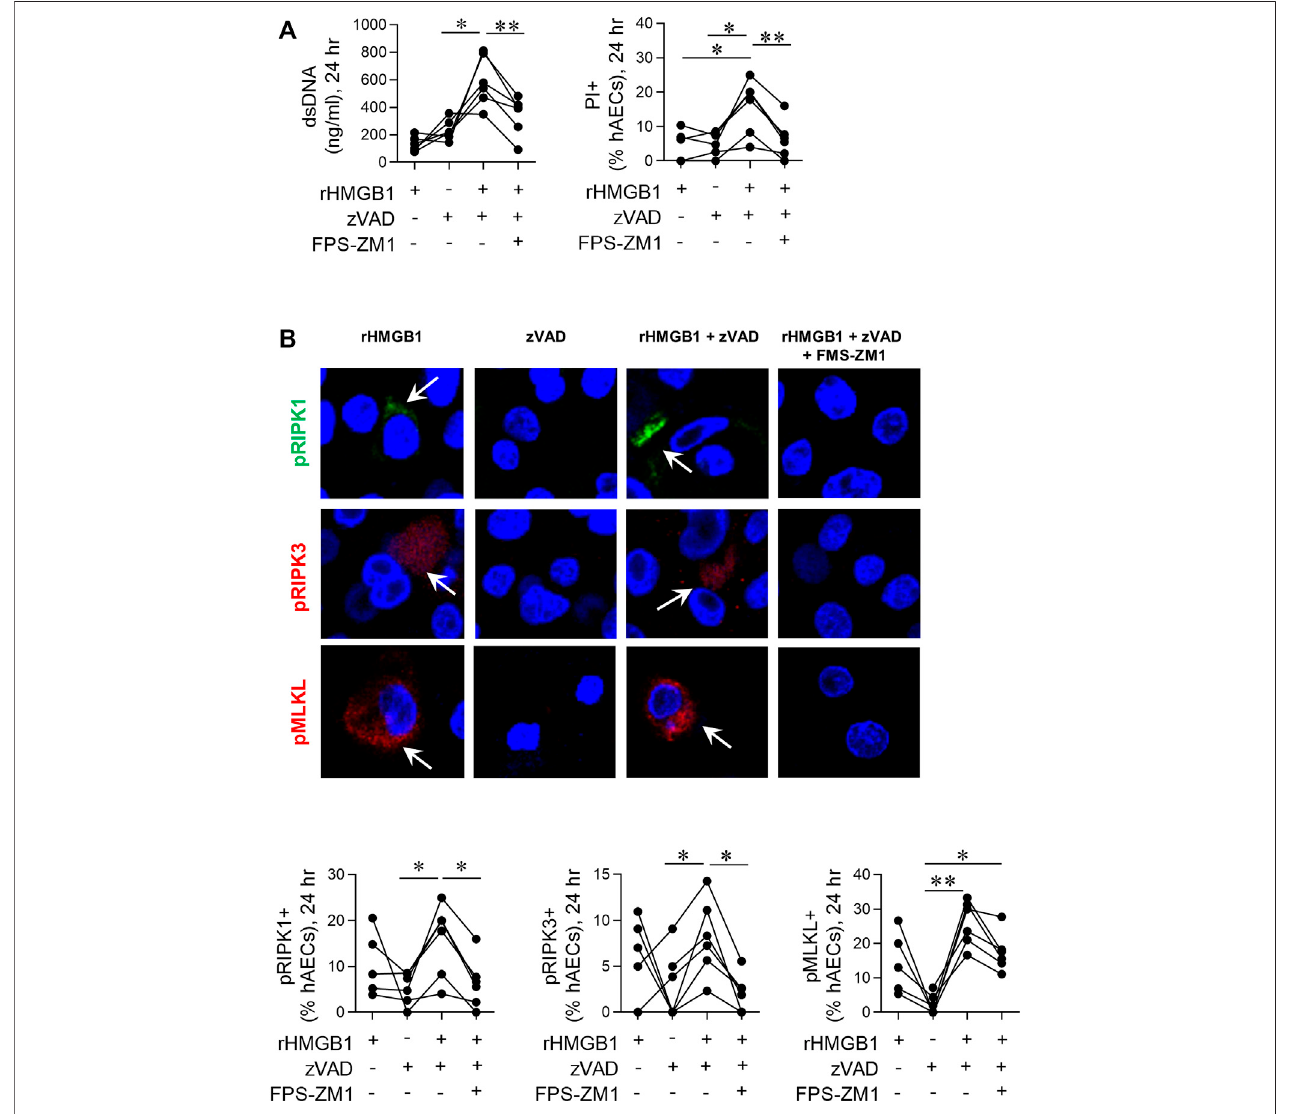
FIGURE 5 | Exogenous HMGB1 and caspase inhibition induces necroptosis in hAECs. hAECs were pre-treated with a RAGE antagonist, zVAD and/or disulphide HMGB1 as indicated. Endpoints were assessed at 24 hpi. (A) dsDNA levels in the supernatant and quanti fi cation of PI positive hAECs. (B) Representative images (magni fi cation ×40) and quanti fi cation of pRIP1K, pRIPK3 and pMLKL positive hAECs. Data are presented as dot plots with each data point representing one of 5 or 6 donors. Data are analyzed as a one-way ANOVA or mixed effects analysis and Sidhak ’ s multiple comparisons test. * p < 0.05, ** p < 0.01, denotes signi fi cance between different treatment